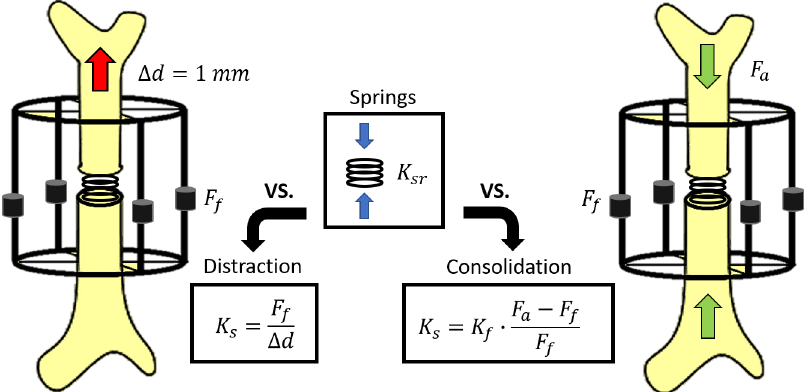
Figure 9. Scheme of the bone-fixator model to estimate the stiffness of the bone callus during the distraction phase (left) and the consolidation phase